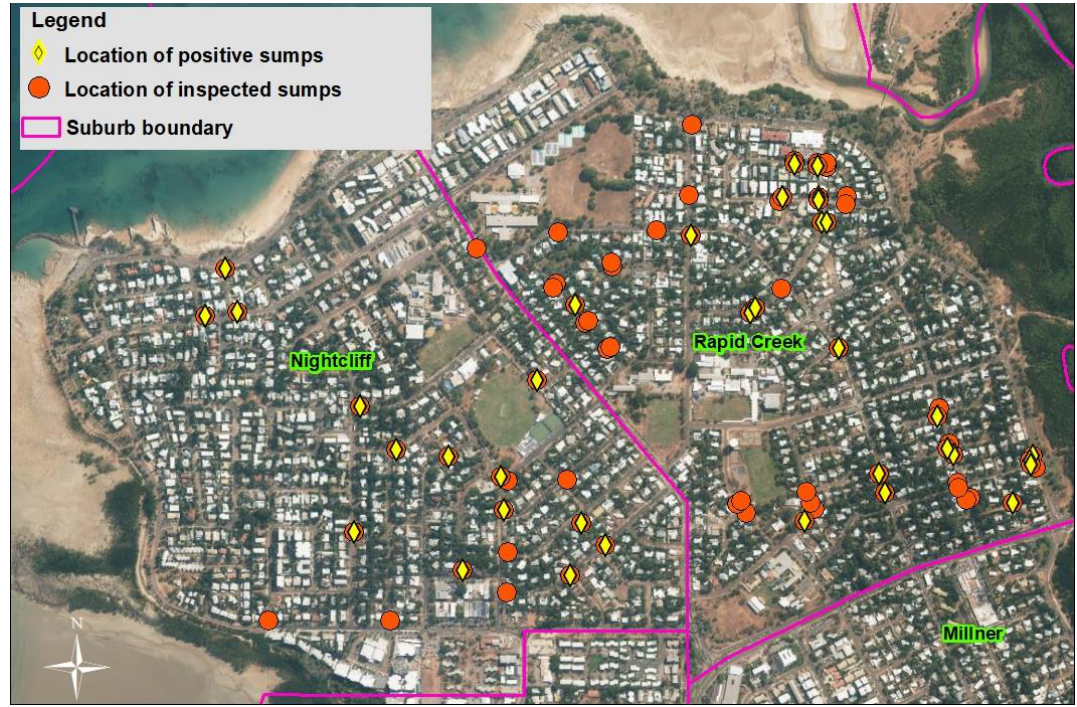
Figure 2. Location of surveyed side entry pits and sumps positive for mosquito larvae.